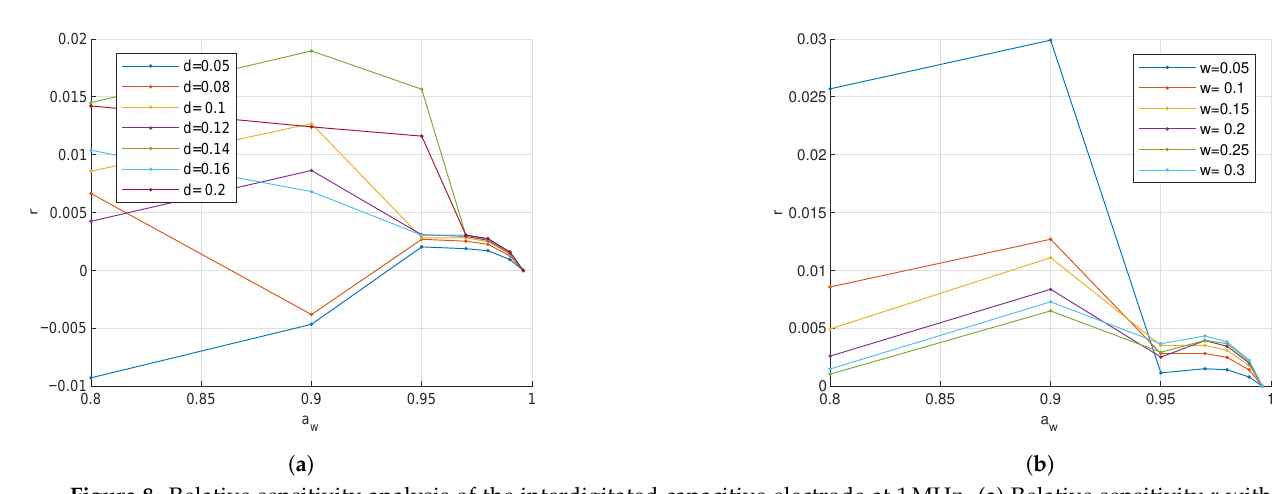
Figure 8. Relative sensitivity analysis of the interdigitated capacitive electrode at 1MHz. ( a ) Relative sensitivity r with varying electrode gap: Parameter d is the electrode gap between the electrode fingers in mm. The electrode width was kept at 0.1mm. Increasing the electrode gap increases the sensitivity. ( b ) Relative sensitivity r with varying electrode size: Parameter w is the electrode width of the electrode fingers in mm. The electrode gap was kept at 0.1mm. In a higher water activity range a w > 0.95, the wider the electrode, the better the sensitivity. In a lower water activity range a w < 0.95, the smaller the electrode width, the better the sensitivity.